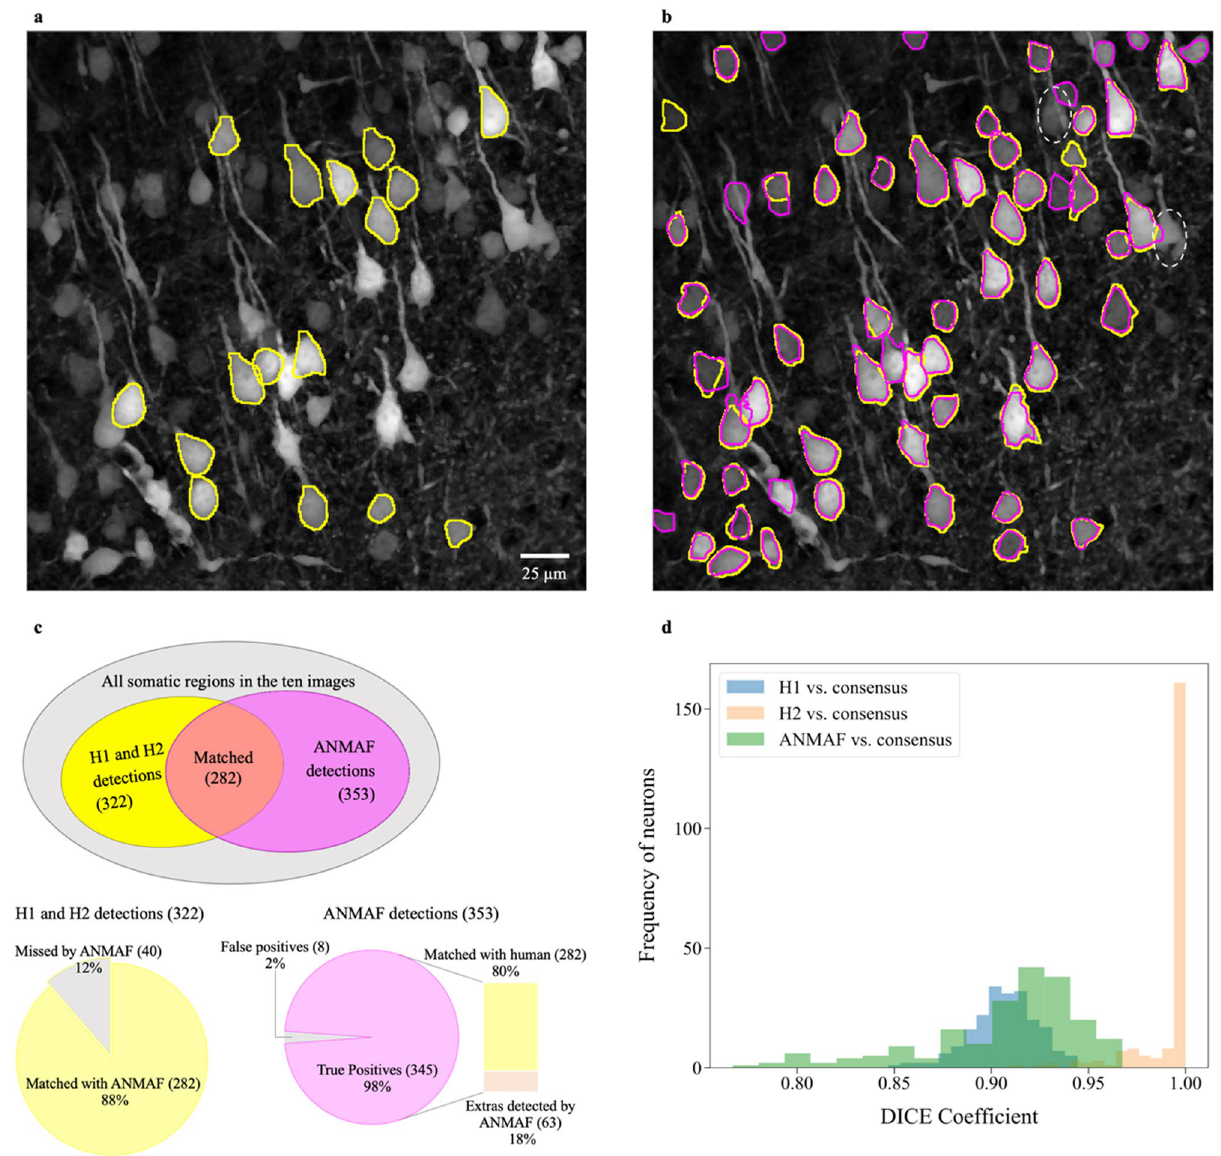
Figure 3. ANMAF exhibited high precision. ( a ) A selected real image with original annotations. Human annotators initially contoured only a small subset of visually prominent somatic regions. ( b ) The same image was relabeled by two human annotators to contour as many somatic regions as possible to compare with ANMAF. Yellow, human-labeled contours; Magenta, ANMAF generated segmentations. White dashed ellipses indicate two somatic regions that both the human annotators and ANMAF could not segment. ( c ) Human H1 and H2 together identified 322 somatic areas, and ANMAF detected 353 ROIs from the ten images. There were 283 regions in common. Note that neither the human annotators nor ANMAF identified every single somatic region. ANMAF detected 88% of regions labeled by the human annotators. Among the 353 somatic ROIs detected by ANMAF, 98% of them were somatic regions. ( d ) DICE coefficient histogram of H1, H2, and ANMAF against the human consensus using the STAPLE algorithm. ANMAF performance was between H1 and